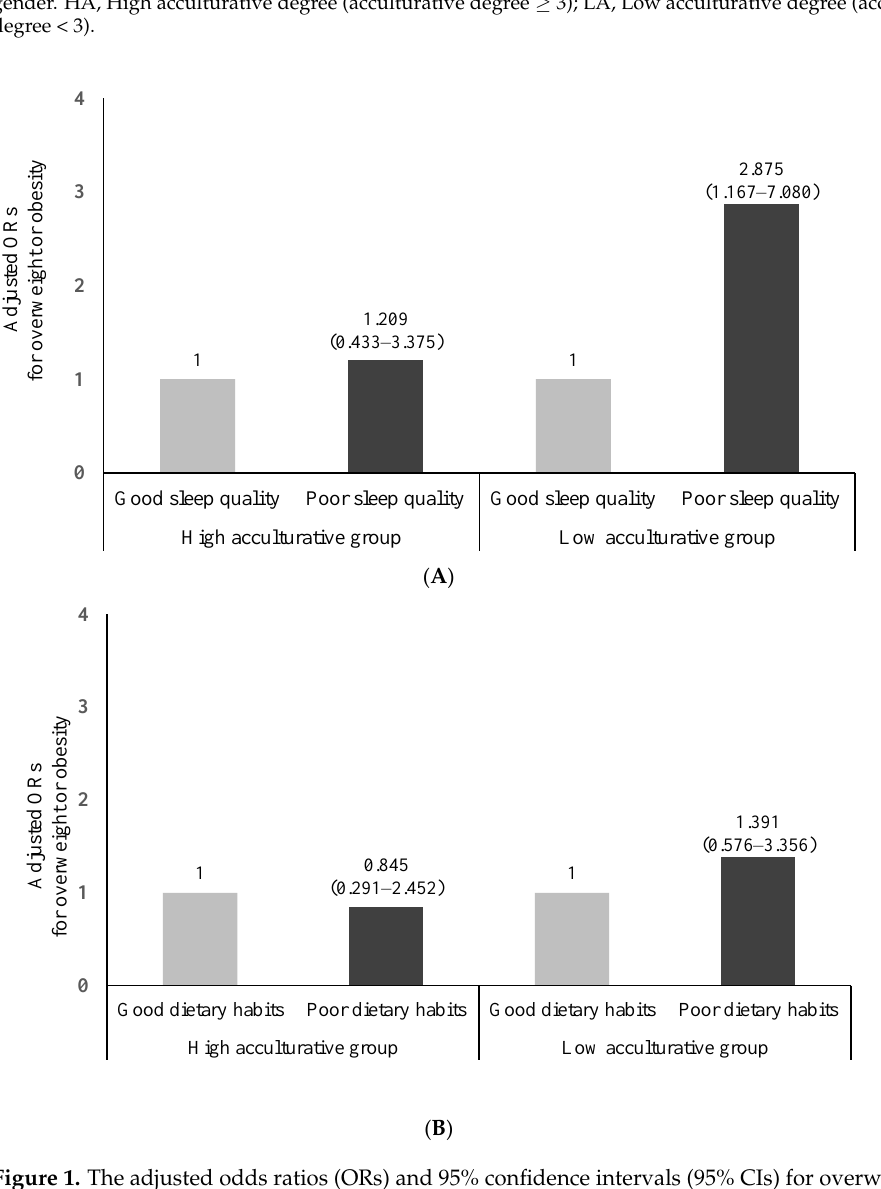
Values represent means ± SD. * p values were calculated using a generalized linear model adjusted for age and gender. HA, High acculturative degree (acculturative degree ≥ 3); LA, Low acculturative degree (acculturative degree < 3).